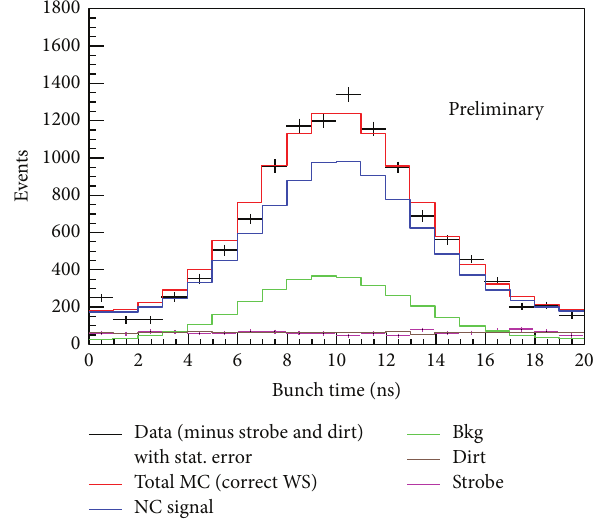
Figure 18: (Color online) The reconstructed NCE event time profile for the antineutrino mode beam. The events are overlaid relative to the bunch center. As expected, the data peaks in the bunch center, which means these are dominated with antineutrino interactions and there is no delay of